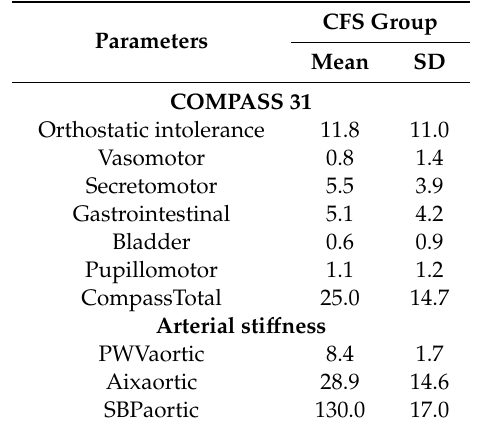
Table 2. Detailed clinical characteristics of all patients with Chronic Fatigue Syndrome